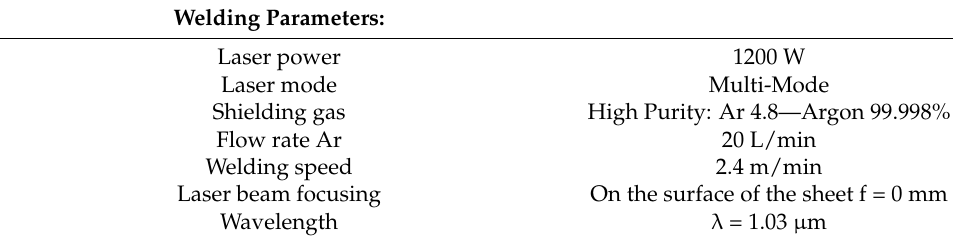
Figure 1. Set-up of materials to be welded. Welding parameters were chosen based on the preliminary experiments. Used welding parameters and quality evaluation methods are in Table 3. Table 3. Used welding parameters and welded joints evaluation methods.